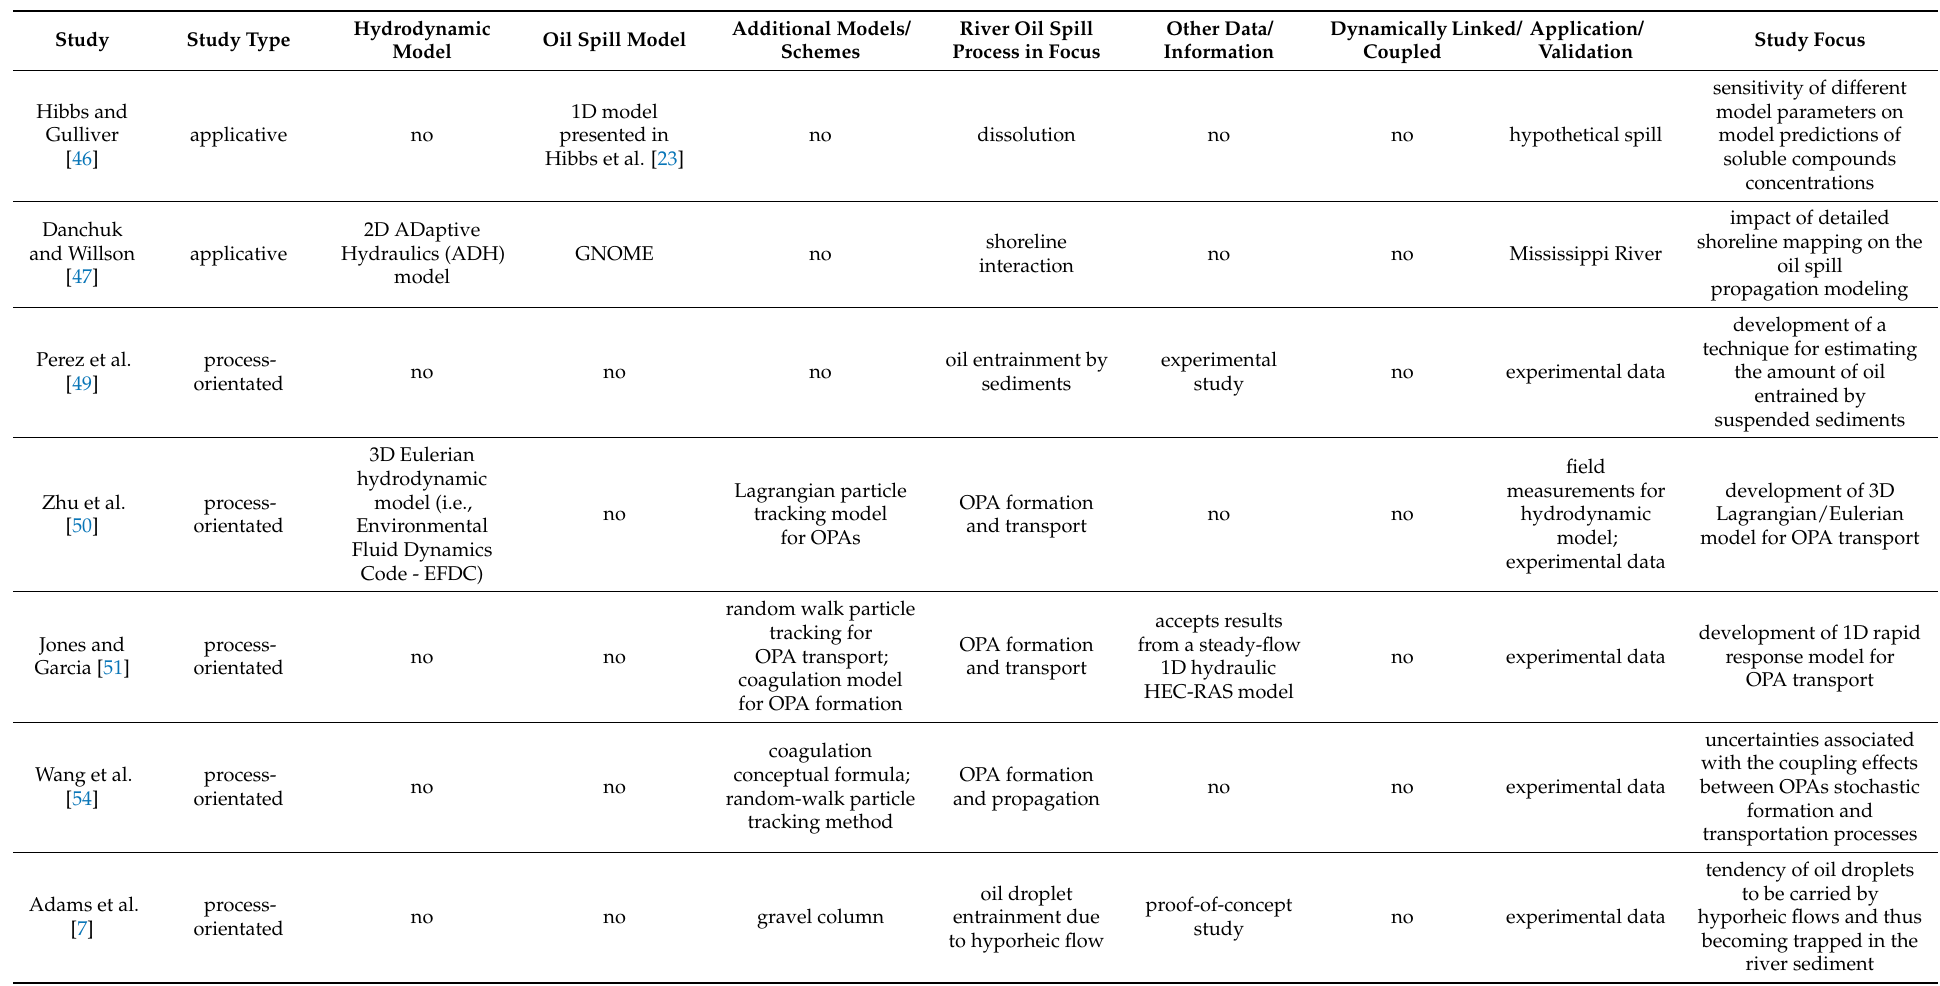
Table 3. Applicative and process-oriented